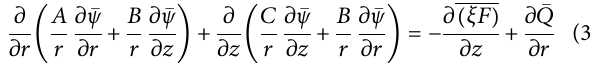
Frontiers in Earth Science |